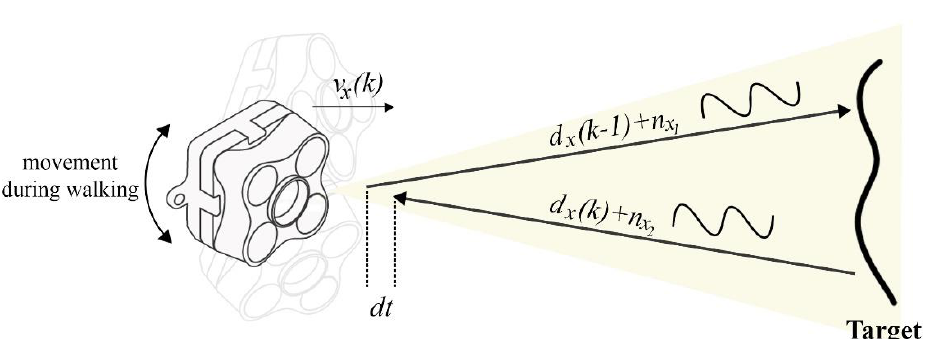
Figure 5. Input and output signals of a ToF sensor in front of a solid